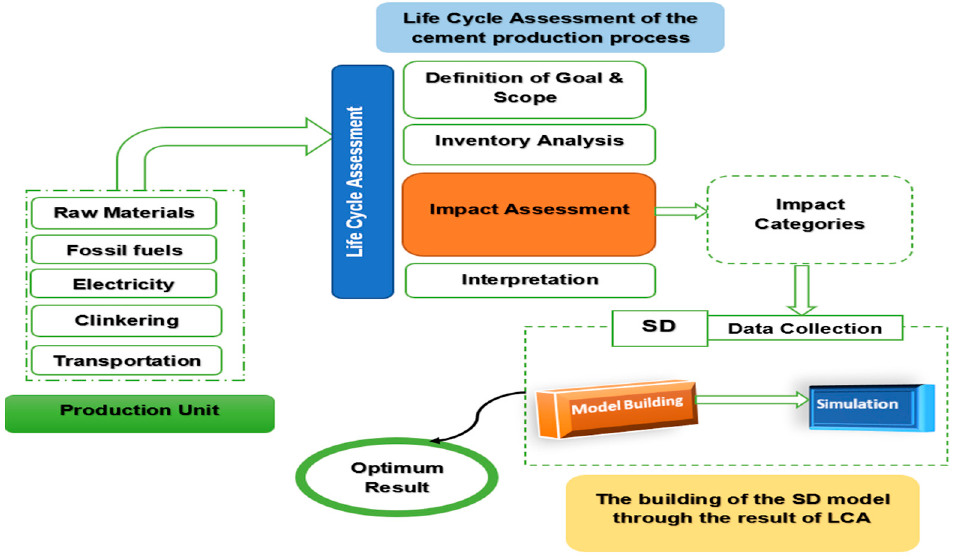
Figure 1. The framework of the integrated LCA and SDs methods for cement production.